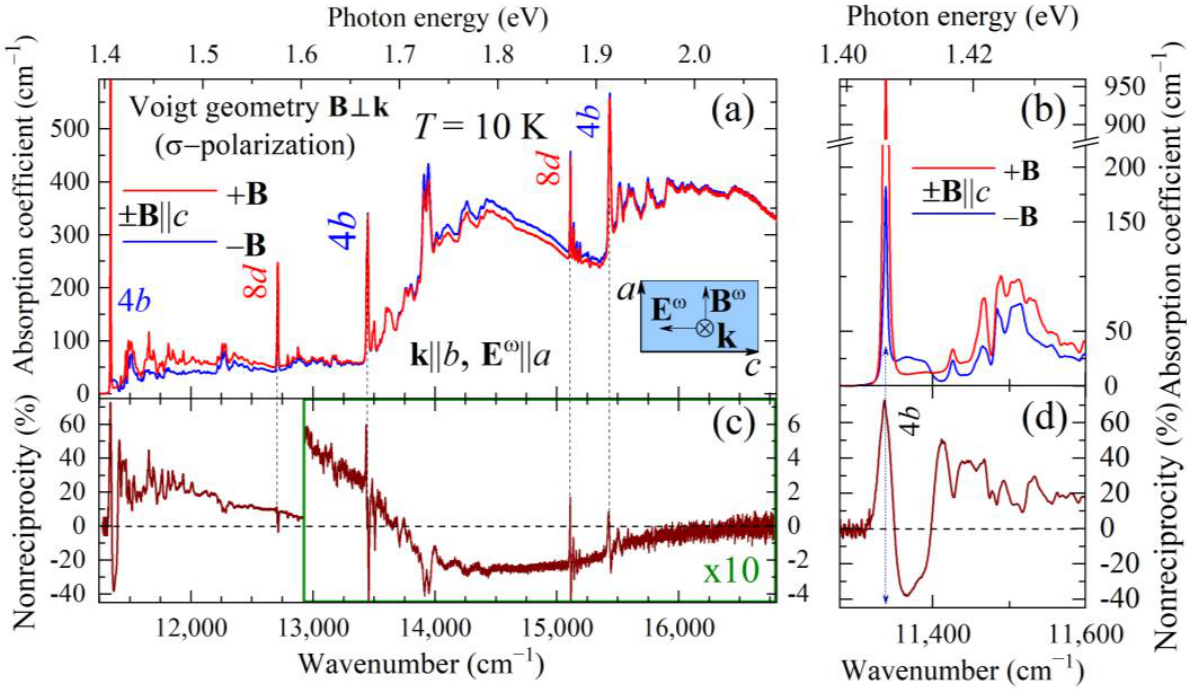
Figure 5. ( a , b ) Absorption and ( c , d ) NDD spectra of CuB 2 O 4 at T = 10 K ( T * < T < T N ) in an external magnetic field directed along the c axis of the crystal, B ∥ c , B = ± 0.2 T, the Voigt geometry k ∥ b , σ polarization E ω ∥ a . ( a , c ) The whole spectral range of the 4 b and 8 d exciton transitions and ( b , d ) re- gion near the lowest-frequency 4 b exciton transition at an expanded scale.